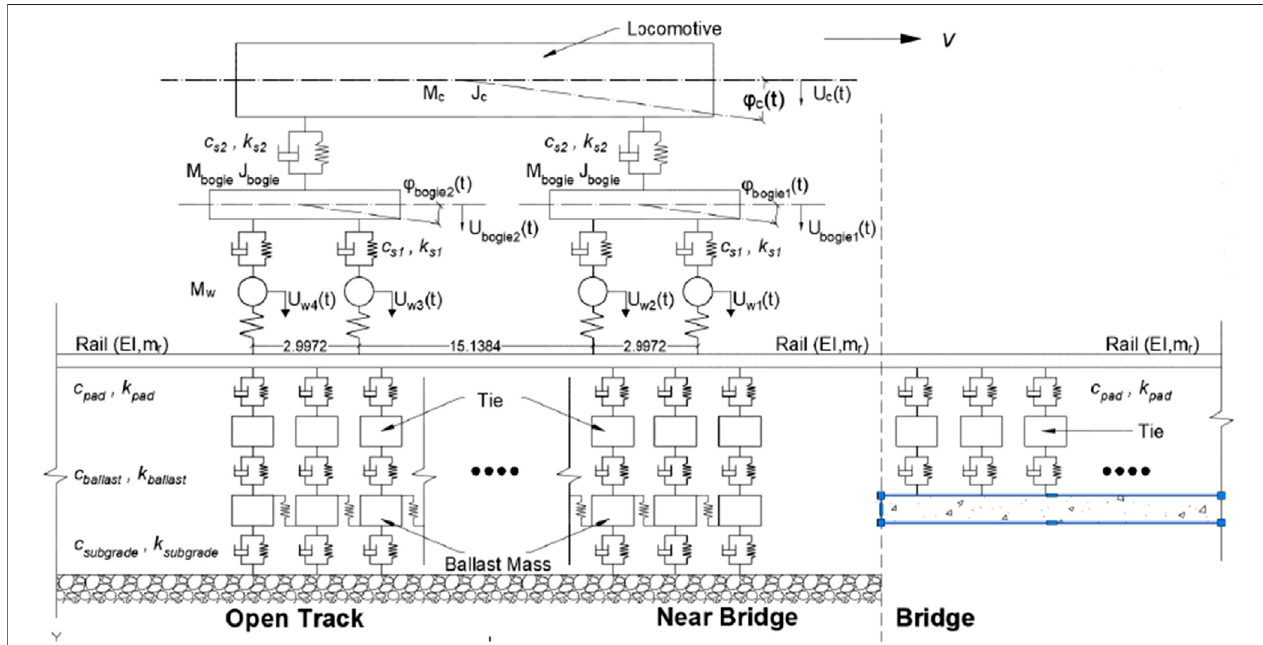
FIGURE 2 | Schematic of discretely supported train-track-bridge model (from Hou et al., 2021).